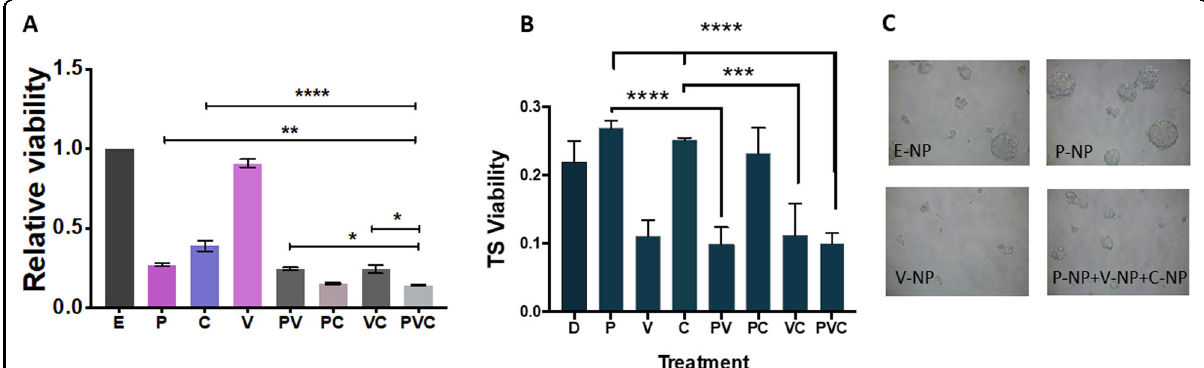
Fig. 1 Combination of vertepor fi n-NP, paclitaxel-NP, and/or combretastatin-NP suppressed both bulk tumor cells and cancer stem cells. A The viability of TNBC MDA-MB-231 cells was determined by MTT assay after 120-hr treatment with E-NP (empty-nanoparticle), P-NP (paclitaxel-NP, 5 nM), V-NP (vertepor fi n-NP, 250 nM), C-NP (combretastatin-NP, 5 nM), or different combinations. B Tumorsphere (TS) formation, an in vitro assay indicating cancer stem cells (CSCs) after different treatments with drug-NPs. MDA-MB-231 cells overexpressing E-cadherin were grown in low attachment and serum-free conditions, and treated for 120 hrs as described in A , followed by MTT viability assay. C Representative photographs of TS shown in B . Data represent means ± SD, * P < 0.05, ** P < 0.01, **** P <